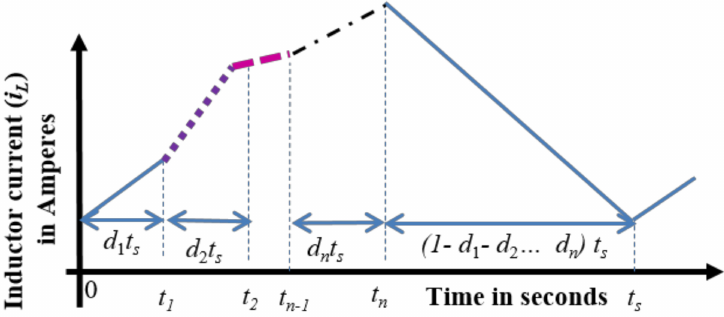
Figure 2. Timing diagram of various modes of operations of SIMO and MIMO